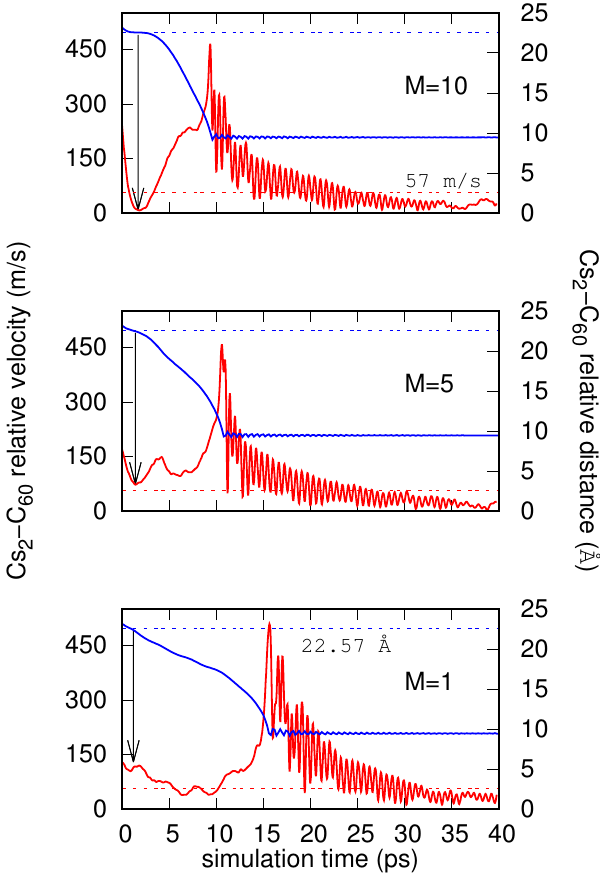
Figure 7. Evolution of relative Cs 2 -C 60 distance (blue solid lines) and velocity (red solid lines), plotted as a function of time, and obtained through simulations for M beads ( M = 1, 5, and 10) but with different initial relative velocities of v 0 = 129 m/s ( M = 1), 169.4 m/s ( M = 5), and 239.8 m/s ( M = 10). Landau critical velocity and crossing distance between neutral and ionic potential energy curves at T-shaped initial orientation are also shown with dashed red and blue lines, respectively. Arrows indicate relative velocity of reactants when they get crossing distance between neutral and ionic potential energy curves.